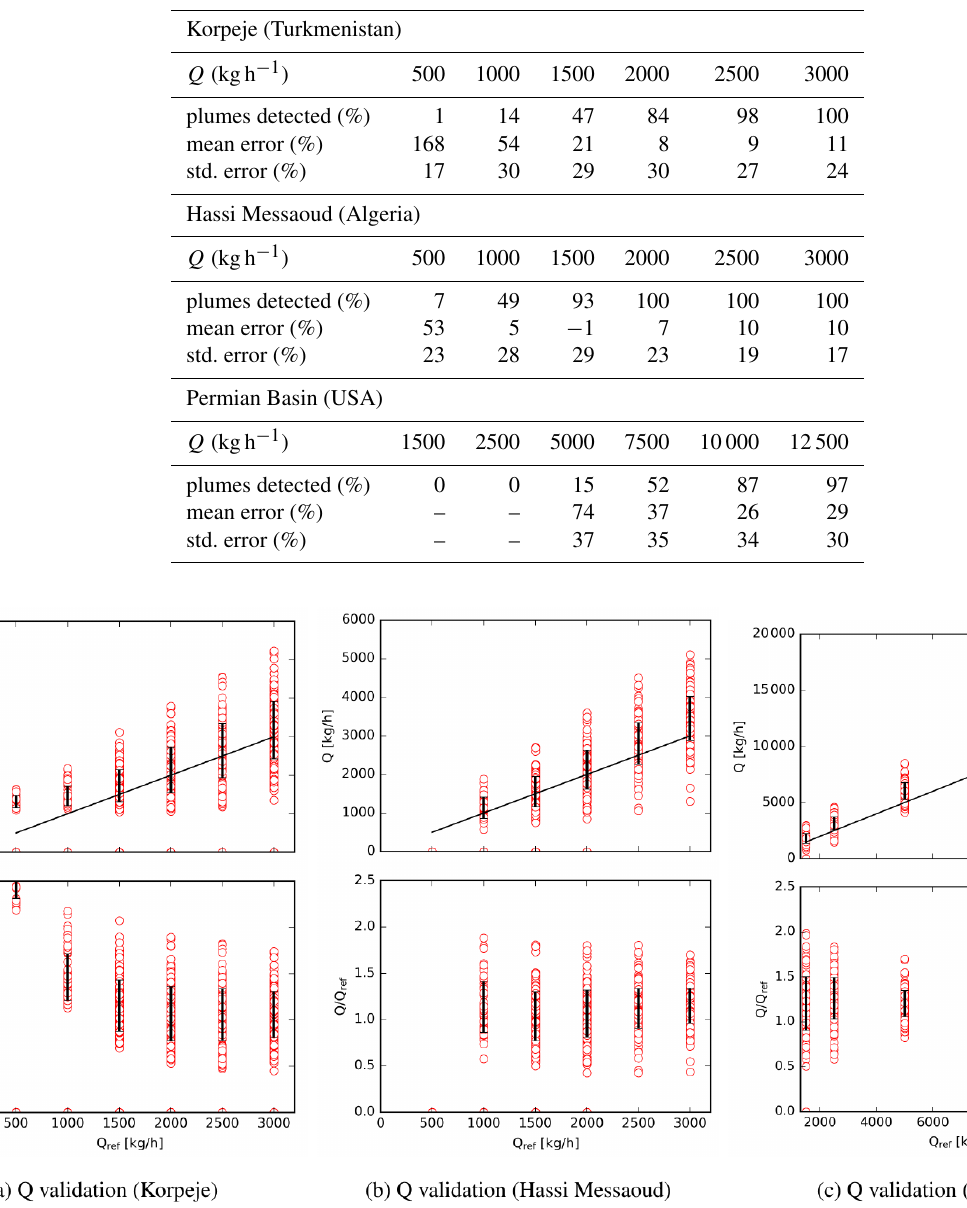
Table 2. Statistics associated to Fig. 11. This includes the percentage of plumes detected, the mean error and standard deviation against simulated benchmarks for the selected sites at Korpeje (Turkmenistan) (see Fig. 2a), Hassi Messaoud (Algeria) (see Fig. 2b) and the Permian Basin (USA) (see Fig. 2c) under the supervised masking criteria detailed in Sect. 4.